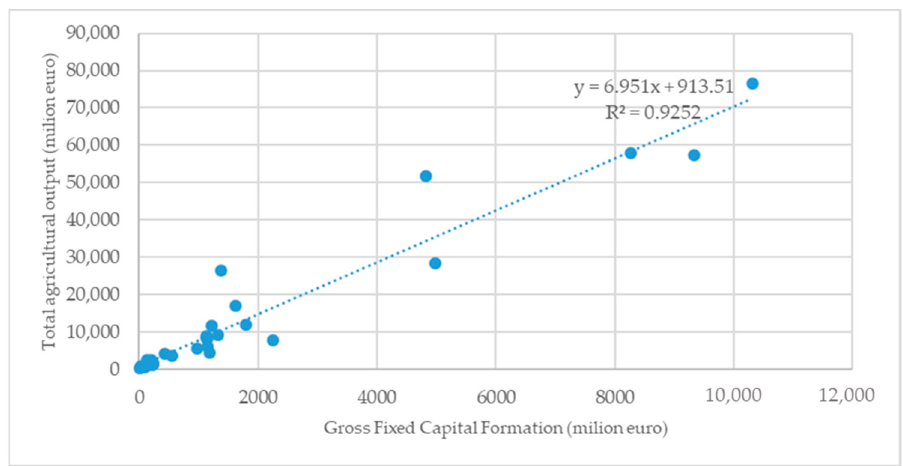
Figure 4. Correlation between gross fixed capital formation and total agricultural output.